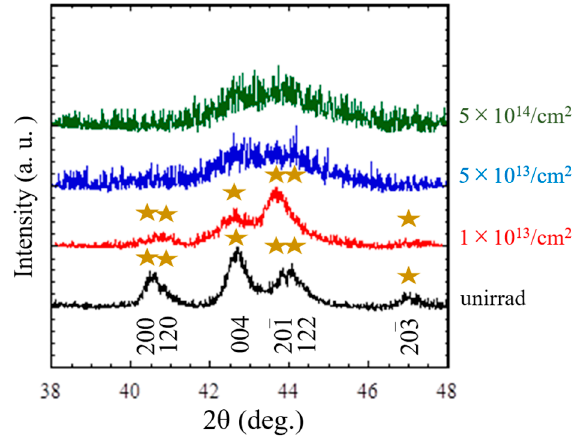
Figure 24. GIXD spectra for unirradiated and 16 MeV Au ion-irradiated Ni 3 Ta. The indices and solid stars in the figure correspond to the monoclinic structure. Ion fluences are shown at the right side of the figure.